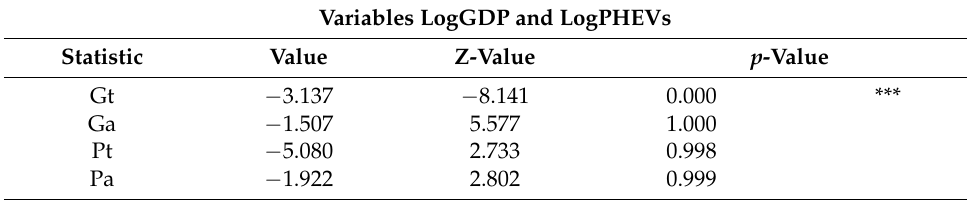
Table 7. Westerlund panel cointegration test.